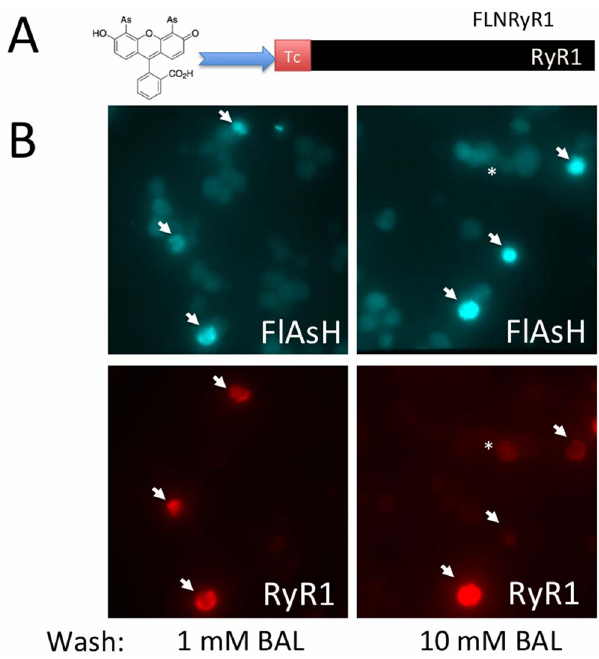
Figure 5. FlAsH labeling of Tc-tagged RyR1. (A) Scheme for FlAsH labeling of RyR1 containing an optimized tetracysteine tag at the N- terminus (FLNRyR1). (B) Cells expressing FLNRyR1 were labeled with FlAsH and then washed with either 1 mM (left panels) or 10 mM BAL (right panels). Panels depict either the FlAsH label (top panels) or RyR1 detected via immunocytochemical analysis using the 34 C anti-RyR antibody (bottom panels). Arrows depict same cells in both the top and bottom panels of each